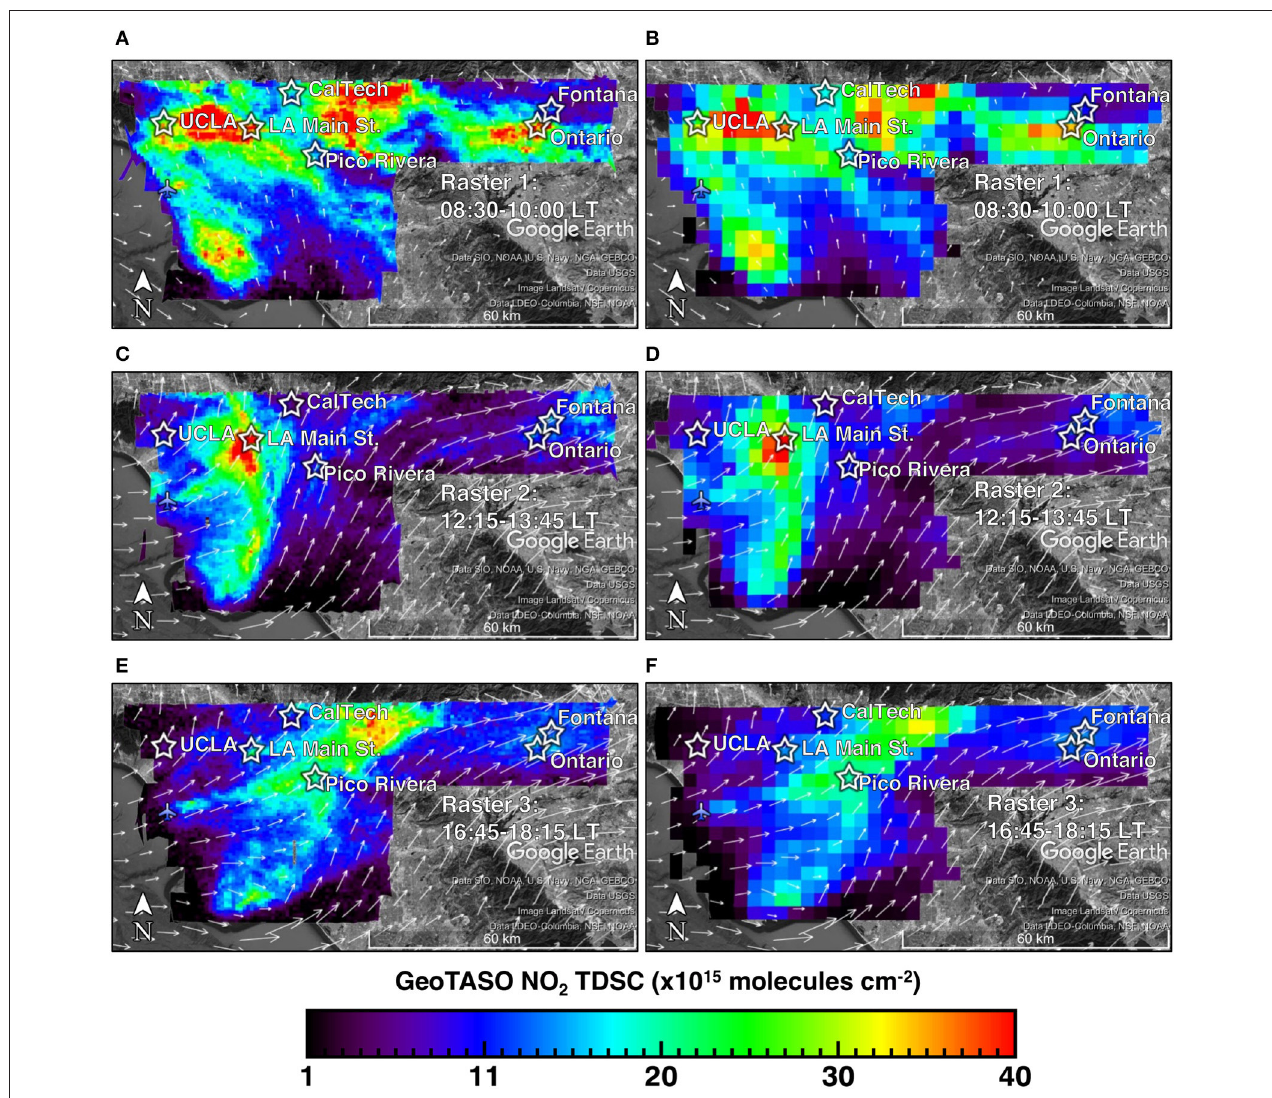
FIGURE 7 | Maps of GeoTASO NO 2 TDSCs over the LA Basin on June 27th, 2017. Raster 1 from 08:30 to 10:00 LT is shown in (A,B) , Raster 2 from 12:15 to 13:45 LT is shown in (C,D) , and Raster 3 from 16:45 to 18:15 LT is shown in (E,F) . Panels (A,C,E) are at 750 × 750m resolution, whereas (B,D,F) are the TDSCs binned to 3 × 3km spatial resolution. Overlaid are the boundary layer averaged wind vectors (white arrows) from the NAM-CONUS 3-km nest analysis for 16:00 UTC (09:00 LT) in (A,B) , 20:00 UTC (13:00 LT) in (C,D) , and 00:00 UTC (17:00 LT) in (E,F) .